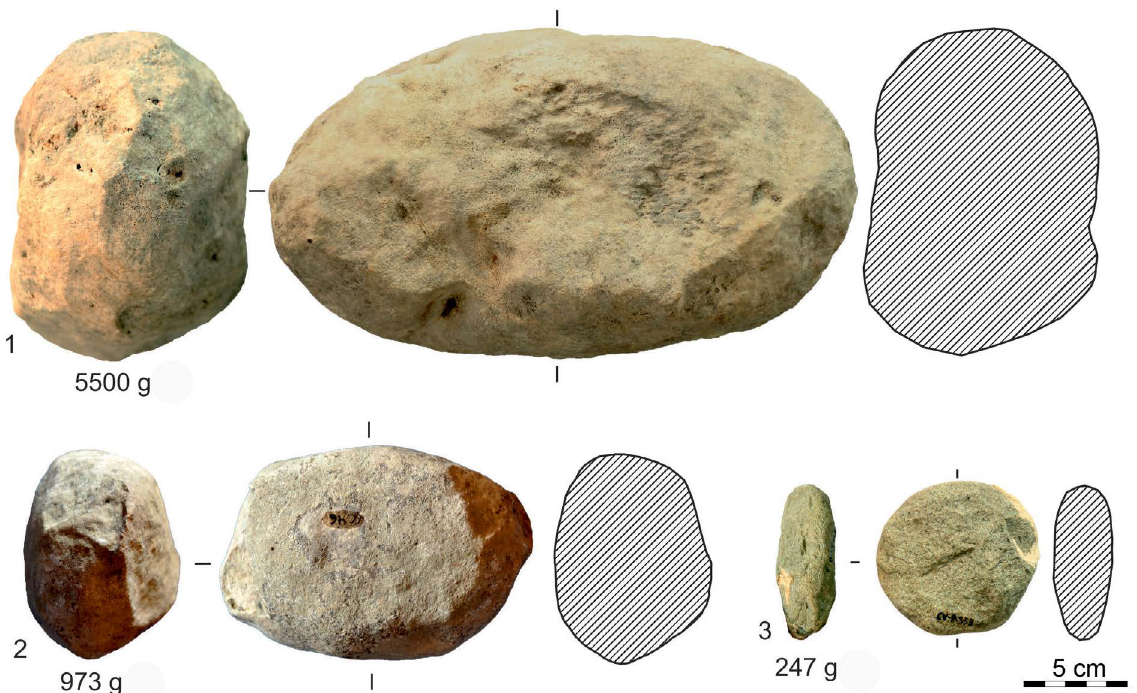
Figure 7. Different types of hammer defined in the quarry. 1. Huge hammer, more than 5kg; 2. Medium hammer, between 1 and 2 kg and 3. Small hammer, less than 1kg. (Scale bar is 5 cm